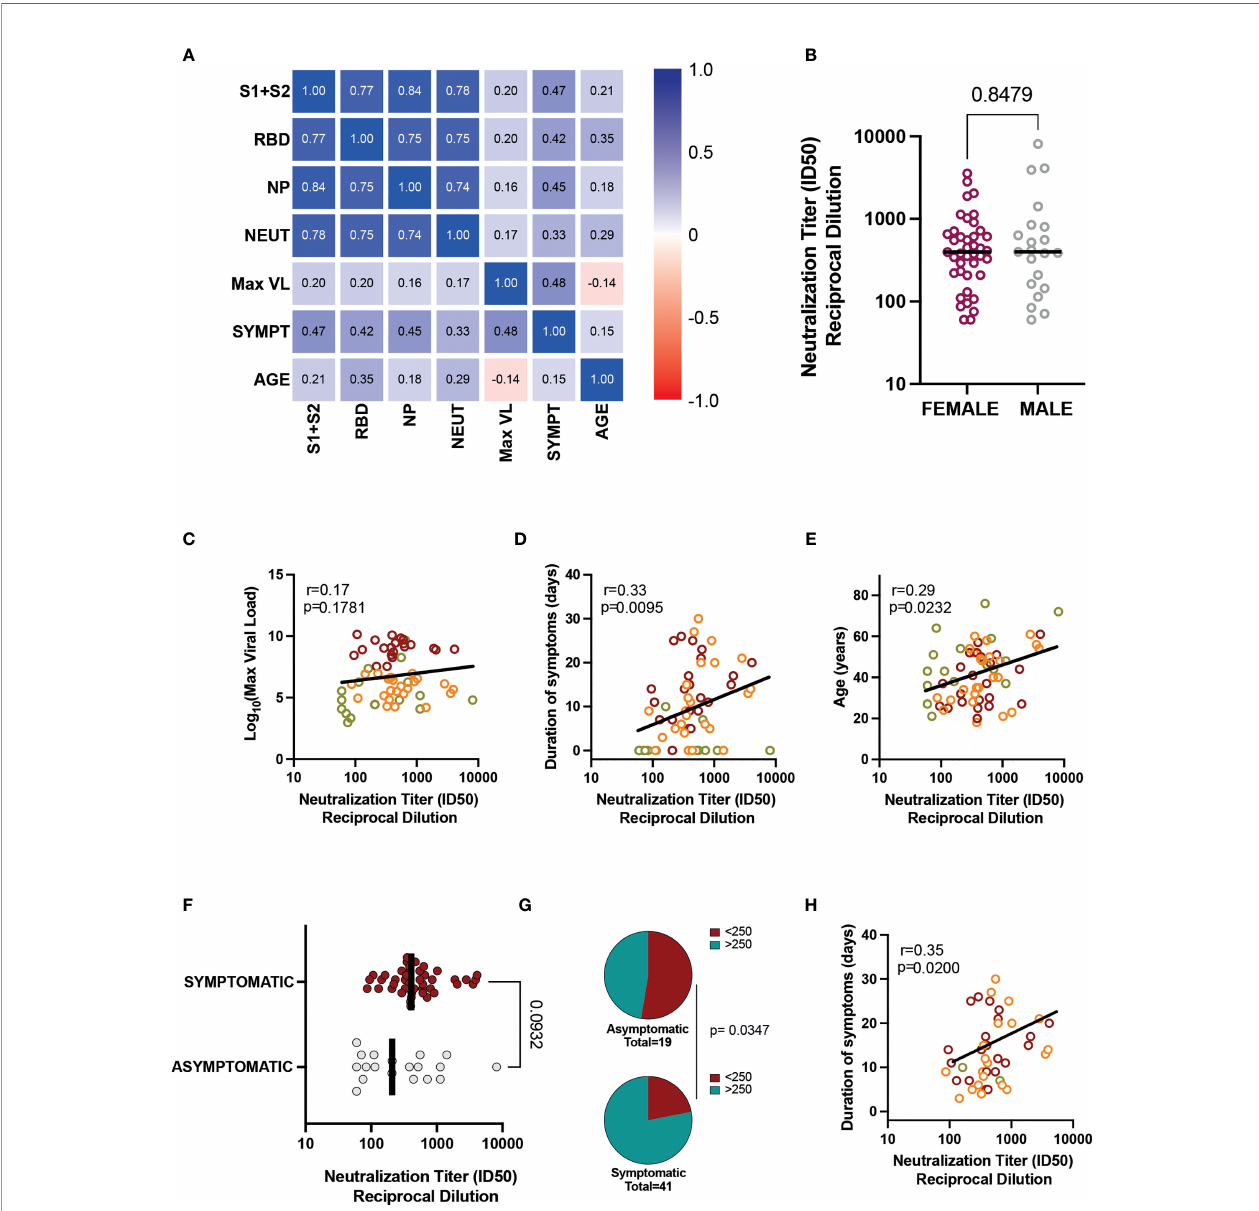
FIGURE 3 | Associations between humoral responses and clinical/demographic characteristics. (A) Heatmap of correlations between total IgG, neutralizing antibody titer, VL, symptom duration, and age for all patients. (B) Neutralization titers in female and male participants (all groups). Bar indicates median values, and the p -value is shown (Mann-Whitney test). Correlation of neutralization titers with (C) VL, (D) Duration of Symptoms, and (E) Age. Individual values are color-coded: green for Non-early seroconverter individuals at diagnosis, orange for individuals with low viral load, and red for individuals with high viral load. Lines indicate linear regression of all values for illustrative purposes. The correlation coef fi cient and p -value (Spearman correlation test) are shown. (F) The impact of asymptomatic infection was assessed by comparing neutralizing titers between all asymptomatic (grey dots) and all symptomatic patients (red symbols). (G) Frequency of low and high neutralizers (cutoff value 1/250); the Fisher exact test p -value is shown. (H) Correlation between symptom duration and neutralization titer in symptomatic individuals. The correlation coef fi cient and p -value (Spearman correlation test) is shown. ID, inhibitory dilution; NP, nucleocapsid protein; RBD, receptor-binding domain; VL, viral